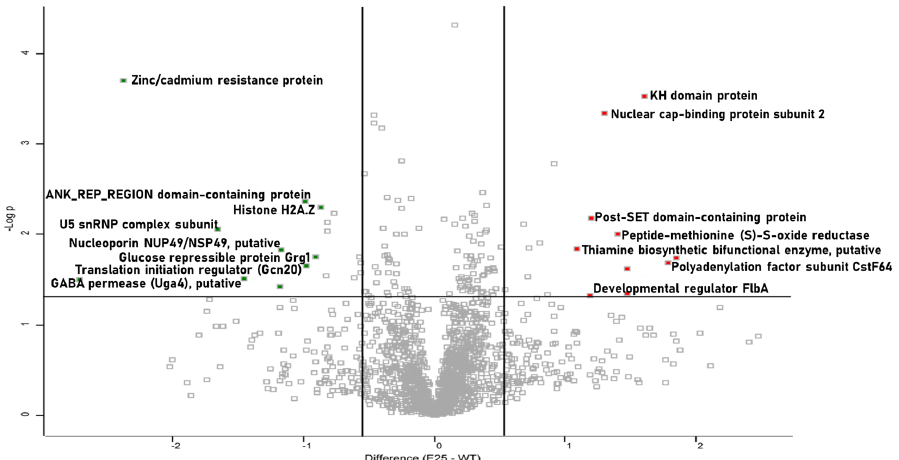
Figure 5. Volcano plots showing alterations in protein abundance in control and passaged A. fumigatus proteomes. Volcano plots of all identified proteins based on relative abundance differences between passaged strains and control mycelia. Volcano plots showing the distribution of quantified proteins. Proteins above the line are considered statistically significant ( p value < 0.05), and those to the right and left of the vertical lines indicate relative fold changes greater than 1.5-fold.